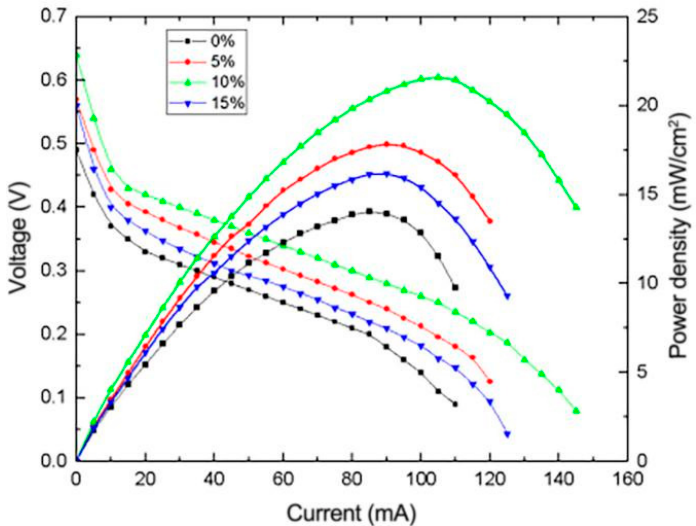
Figure 11. Effect of different Nafion content levels on the performance of μ